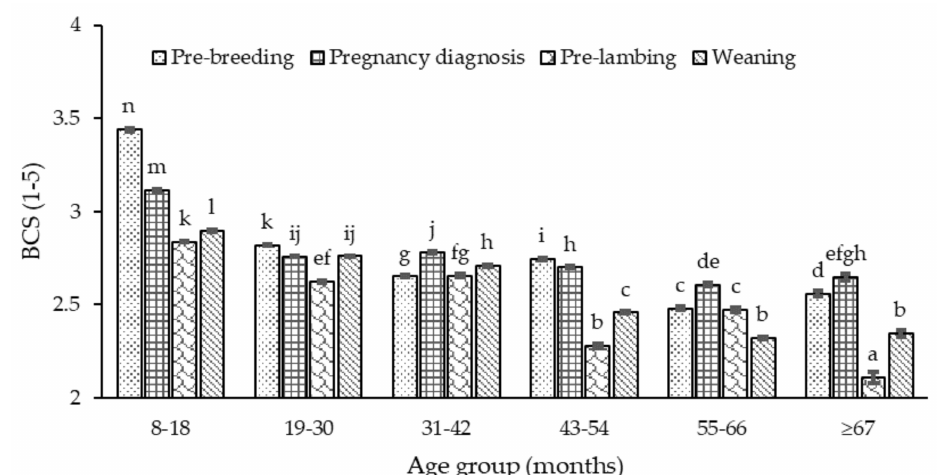
Figure A5. The BCS of ewes across each age group (8–18 months, 19–30, 31–42, 43–54, 55–66 and ≥ 67) and stage of the annual cycle (dotted bar, pre-breeding; grid, at pregnancy diagnosis; shingled, pre-lambing; and stripped-diagonal, weaning). Superscripts a – n indicate significant di ff erences ( p < 0.05) across age group and stage of the annual cycle.